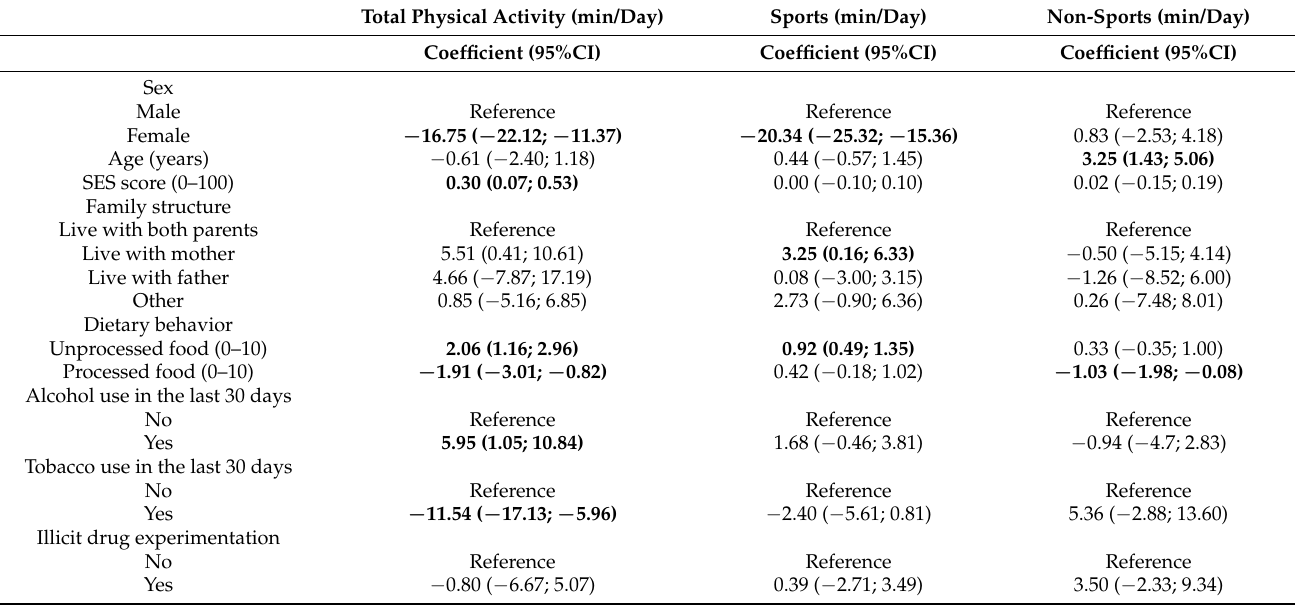
Table 2. Association between sociodemographic, dietary, and substance use factors with physical activity, sports, and non-sport practice in a sample of Brazilian adolescents ( n = 731).